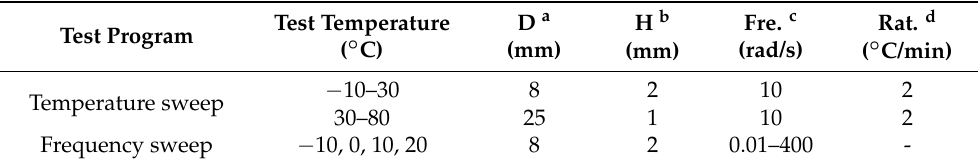
Table 2. Main parameters of DSR